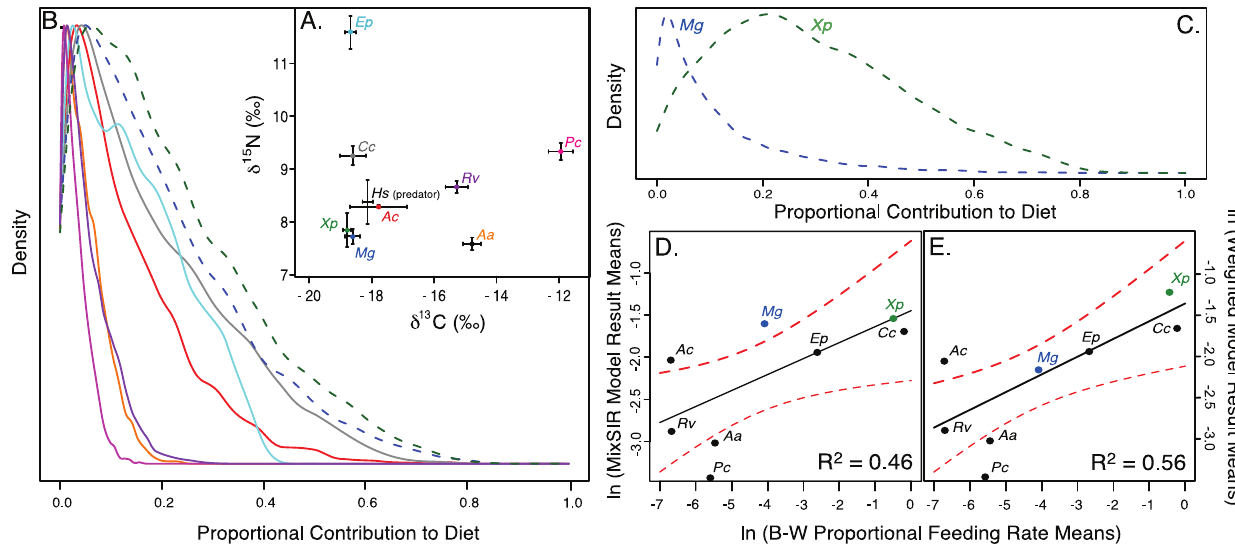
Figure 3. The weighting procedure applied to a New Zealand intertidal community. A ) Isotopic niche space of the New Zealand whelk- predator system, where d 13 C is plotted on the x-axis and d 15 N is plotted on the y-axis. The d 13 C and d 15 N values of the predator Hs are adjusted for trophic discrimination factors (see methods). B ) MixSIR contribution-to-diet posterior probability distributions of all New Zealand prey for predator Hs . Solid distribution density lines denote isotopically distinct prey, whereas hatched distribution density lines denote isotopically similar prey. Prey colors match those of panel 3A. C ) Weighted posterior probably distributions for the isotopically similar prey. Relative abundance values of 0.05 and 0.95 correspond to Mg (blue) and Xp (green), respectively. D ) ln-ln-transformed regression of biomass-weighted proportional feeding rate means vs. original mixing model result means; (slope=0.19, and R 2 =0.46). Hatched red lines represent the 90% confidence interval. E ) ln-ln-transformed regression of biomass-weighted proportional feeding rate means vs. weighted model result means; slope=0.22, R 2 =0.56. Hatched red lines represent the 90% confidence interval.